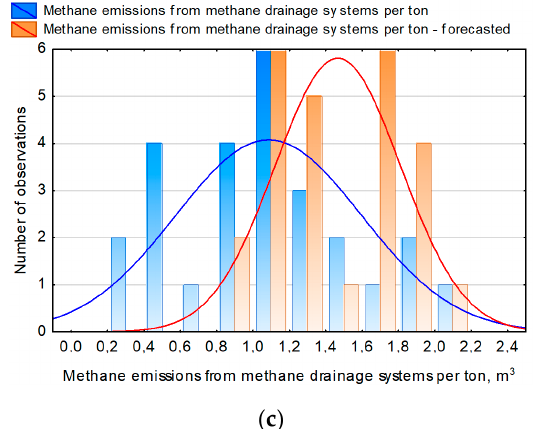
Figure 22. Histograms of the actual and the predicted values of ventilation methane emissions into the atmosphere ( a ), the amount of methane drainage ( b ), and methane emissions from methane drainage systems into the atmosphere ( c ) in relation to one ton of extracted coal.